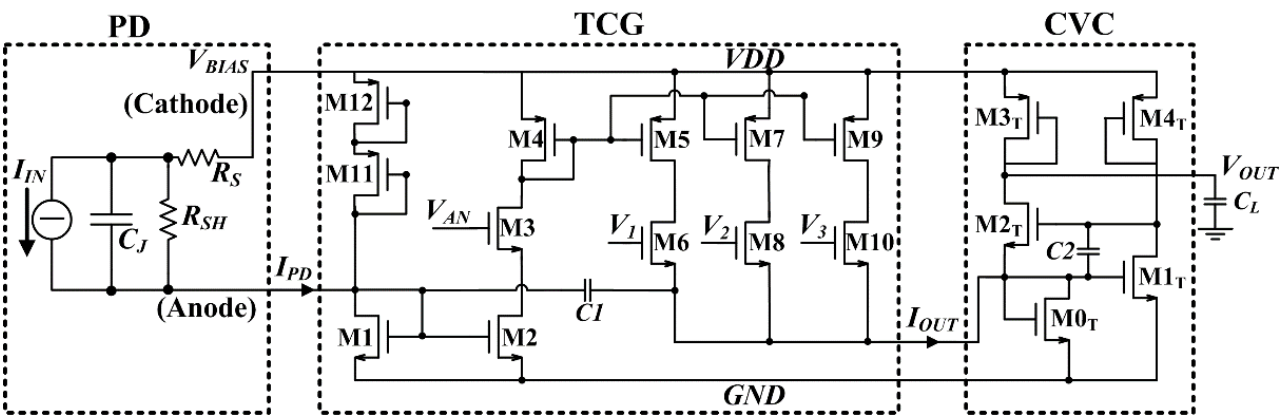
Figure 2. Schematic circuit at transistor level of the CMOS integrated SoC.